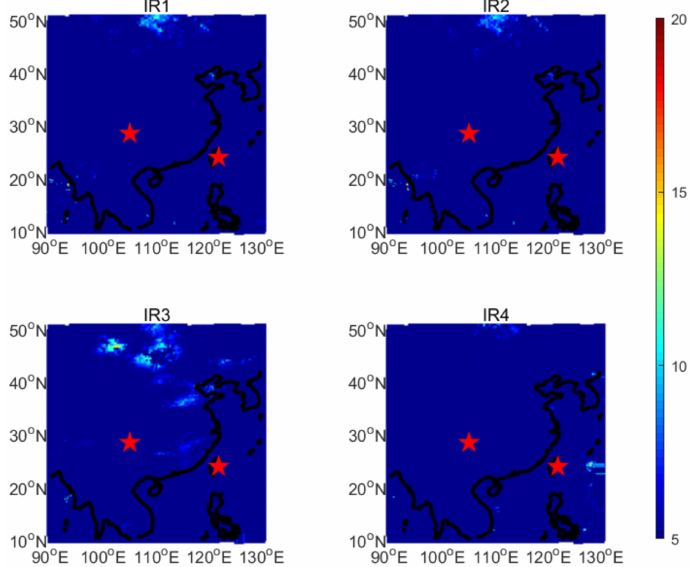
Figure 12. Power spectrum images on 6 December 2018.